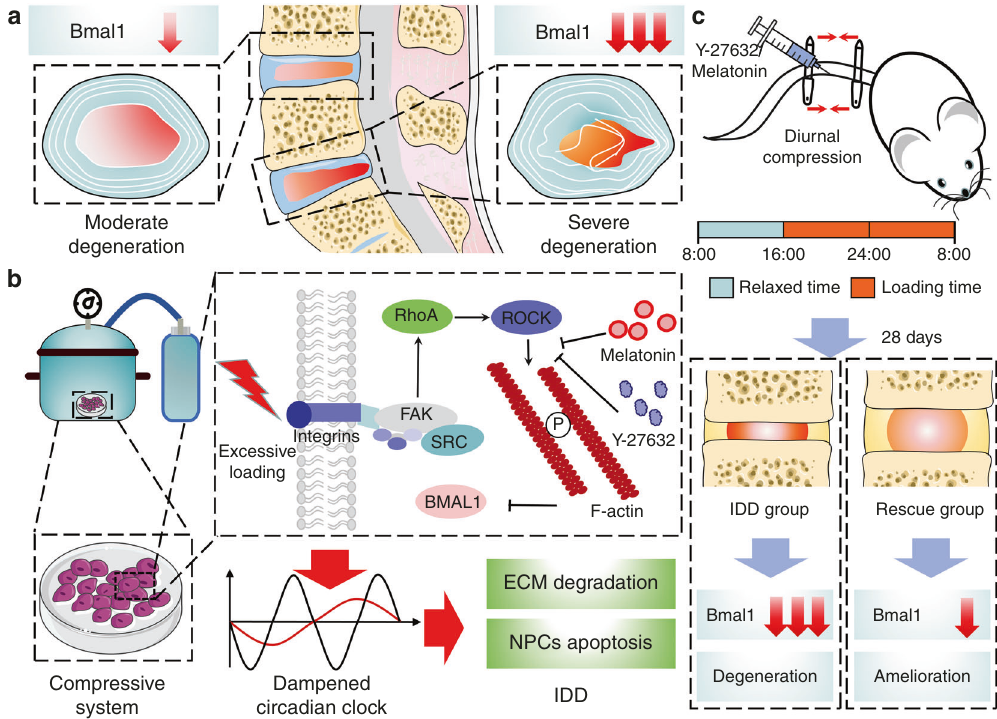
Fig. 7 Proposed schematic representation for this study. a Clinical sample collection and analysis of BMAL1 levels. b Molecular mechanism of excessive loading dampening the circadian clock of IVDs and upregulating BMAL1 expression by RhoA/ROCK pathway inhibition to attenuate compression-induced IDD. c Melatonin and Y-27632 partially restored BMAL1 expression and alleviated IDD in a diurnal compression